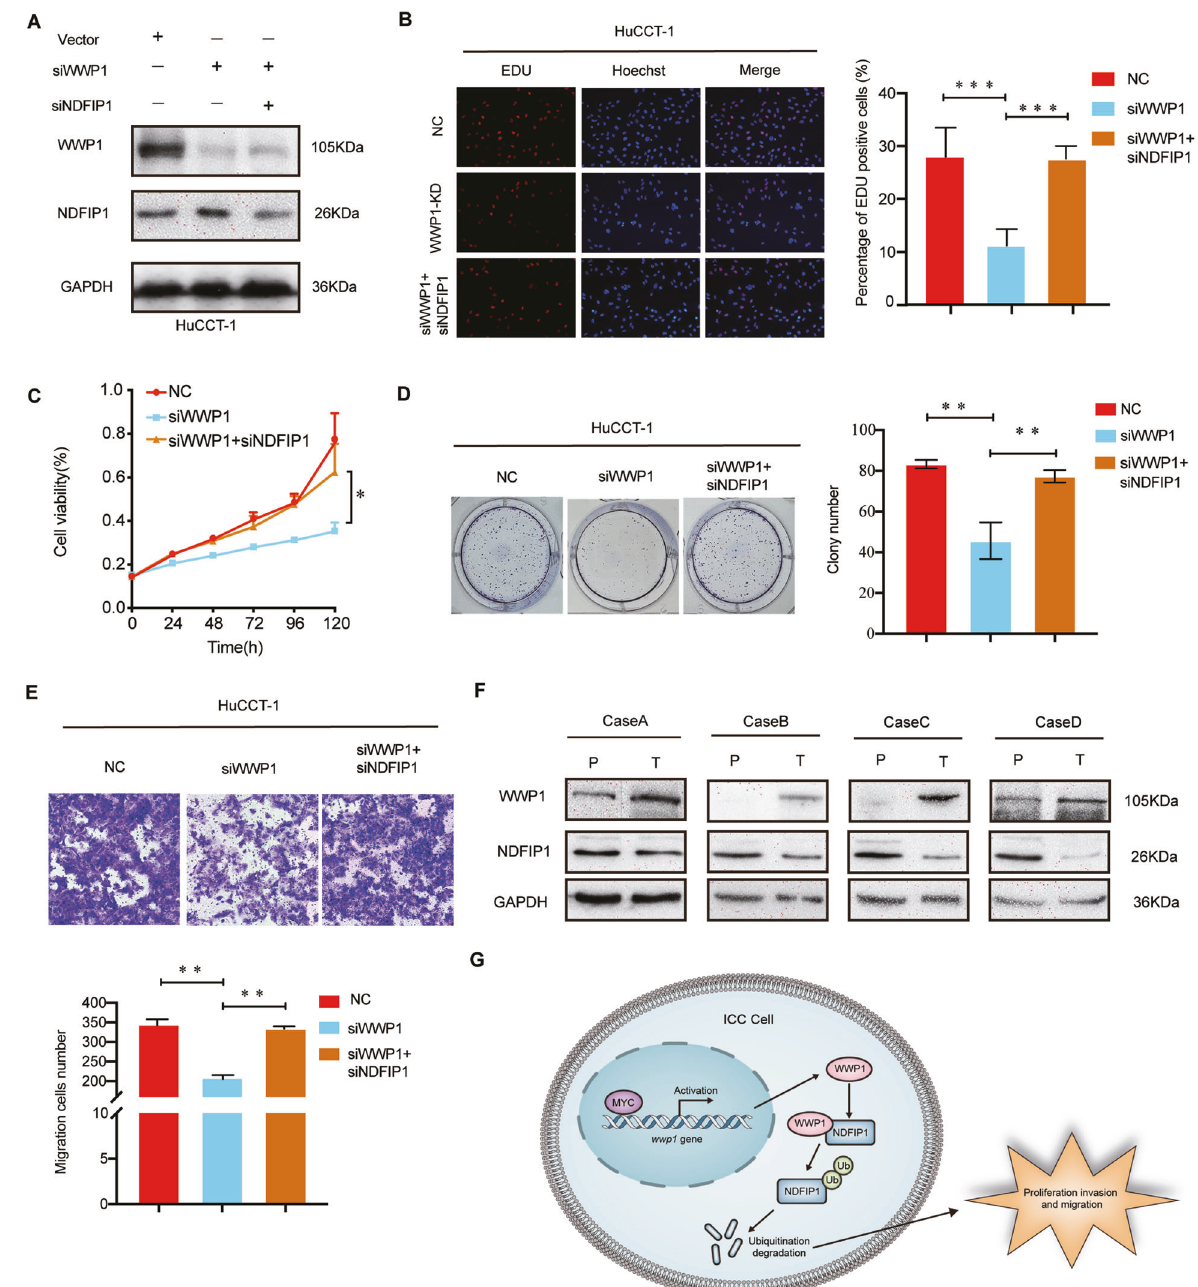
Fig. 8 WWP1 promoted ICC proliferation and migration via negative regulation of NDFIP1. A HuCCT1 cells were transfected with WWP1 siRNA and NDFIP1 siRNA, then western blotting was used to detect the ef fi ciency of transfection. B – D HuCCT1 cells were transfected with WWP1 siRNA and NDFIP1 siRNA, B EdU assay, C CCK-8 assay, and D colony formation assay were applied to estimate the proliferation of HuCCT1, n = 3. E HuCCT1 cells were transfected with indicated siRNA. Transwell assays were performed to detect the migration of HuCCT1, n = 3. F Images of WWP1 protein levels and NDFIP1protein levels in 4 identical ICC tumors and paired adjacent non-tumor tissues by western blotting assays. G A proposed model of how WWP1 regulates the ICC progression: MYC upregulates WWP1 in ICC cells, thereby targeting NDFIP1 for ubiquitination and degradation to promote ICC cell proliferation, migration, and invasion. ** P < 0.01, *** P <